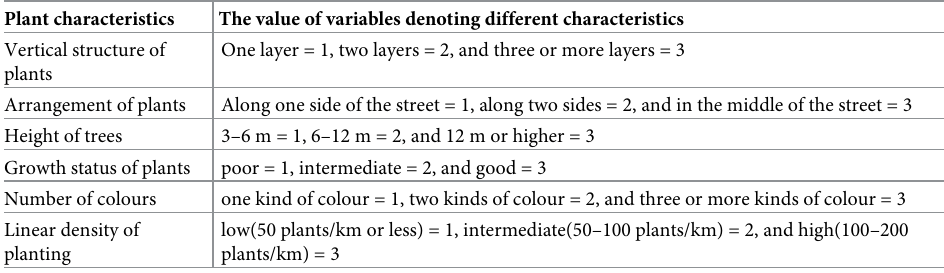
Table 2. Measurement scale of plant